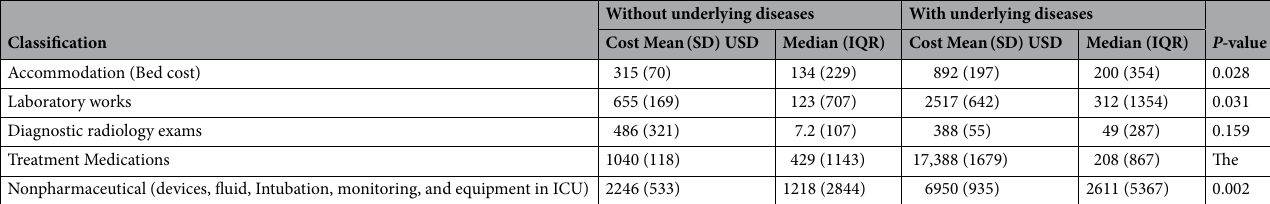
Table 3. Comparative cost analysis for clinical management of COVID-19 cases with and without underlying diseases.